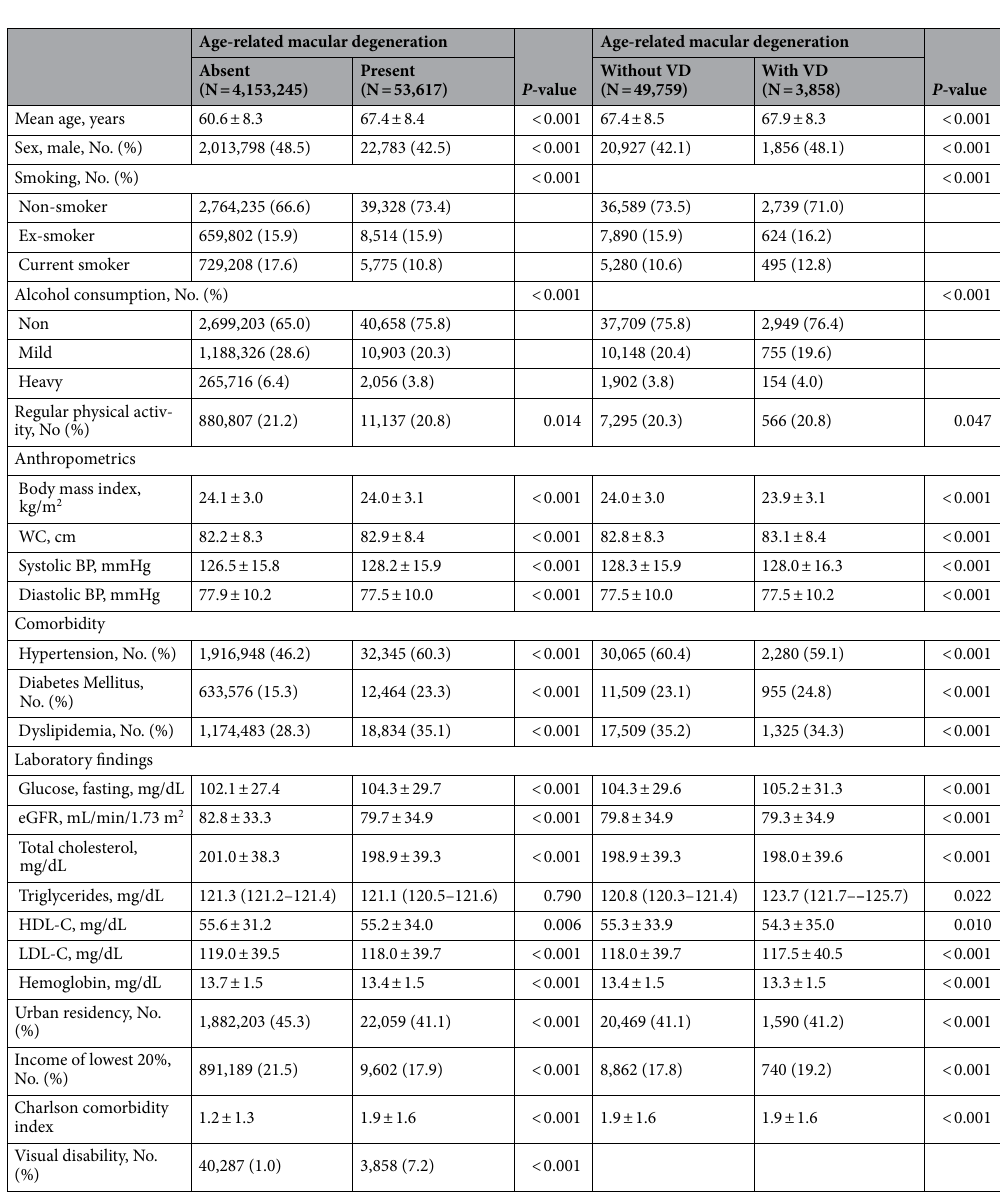
Table 1. Baseline characteristics of the study population. Data are expressed as mean ± standard deviation or number (%). VD visual disability; WC waist circumference; BP blood pressure; eGFR estimated glomerular filtration rate; HDL-C high-density lipoprotein cholesterol; LDL-C low-density lipoprotein